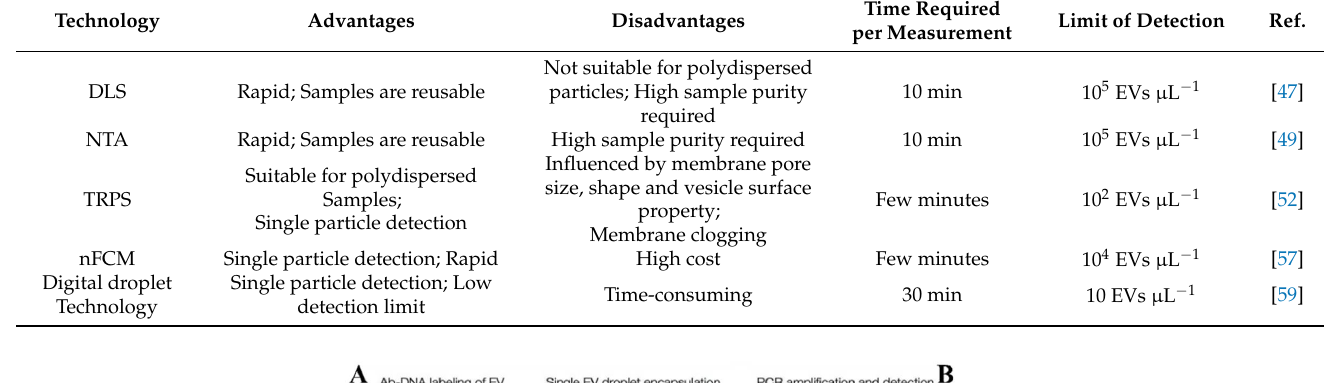
Table 1. Comparison of the different vesicle analysis techniques.